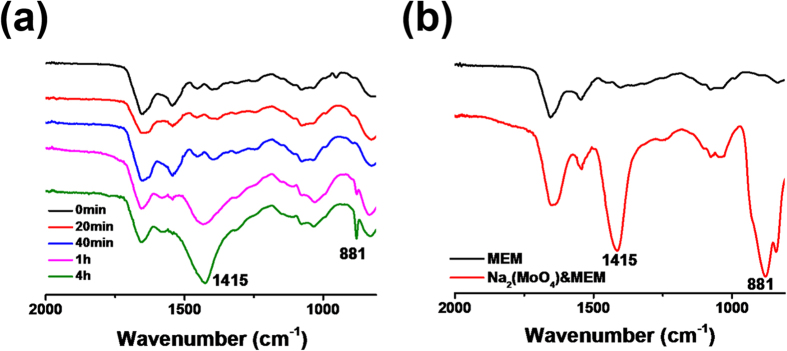
The stability of POM-AMB-acy in MEM solution.(a) Time dependent IR spectrum of POM-AMB-acy in MEM solution. (b) The IR spectrum of MEM solution and Na(MoO4)2 pretreated with MEM for 2 hours.